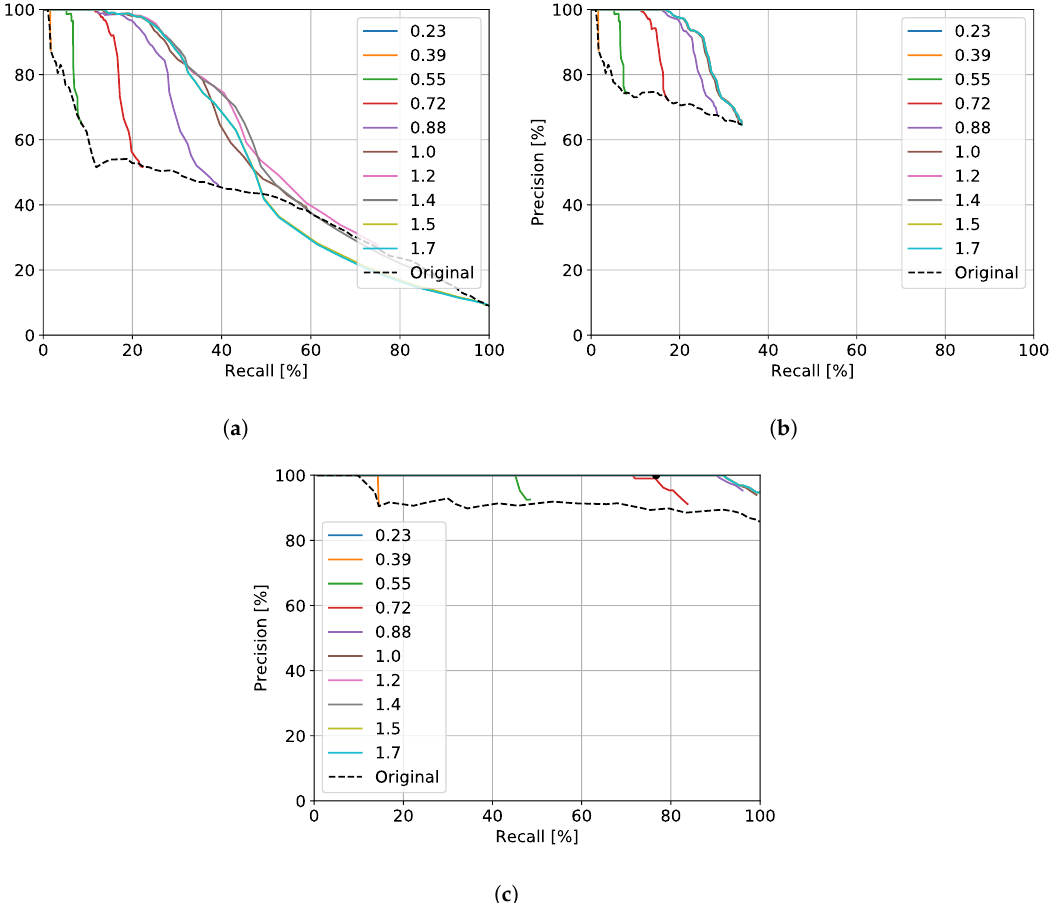
Figure 9. Families of precision and recall (PR) curves for hyperparameters tuning as described in Section 6. These curves represent three different strategies for querying first the visual similarity and then the geometric similarity as measured by Euclidean distance and quality score in the embedding space and pose refinement stages of our pipeline. In ( a ), the legend values show embedding distance thresholds, E , below which all candidates for a match to the query frame are measured for their quality score by pose refinement. The parameter which is varied over each curve is the quality score threshold to take as a “correct” match, Σ , from the most (top) to the least (bottom) strict value. “Original” refers to the results reported in Reference [8] with no pose refinement (only RPR), i.e., as Σ = 0. However, as described in Section 5.3, for online operation, we require that only 5 candidates be passed downstream to the pose refinement submodule; therefore, in ( b ), the 5 closest candidates (also within an embedding distance threshold of E ) are used to compute quality scores which must be higher than Σ to be considered a match. We select the lowest embedding distance that achieves highest recall at 100% precision, i.e., E = 1.0, at a quality score threshold of Σ = 0.421; this is based on tuning the system to the “knee” of the PR curve, where we achieve 100% precision. While before we were considering each candidate singularly, in ( c ) we show the performances of the system considering a successful localisation if the best single candidate—i.e., with the best quality score match from amongst the 5 candidates closest within embedding space—is a positive match. Here, we can achieve much higher recall at 100% precision, but at the cost of sacrificing correctness for all 5 candidates—which may be useful in a multi-particle filtering localisation scheme, for